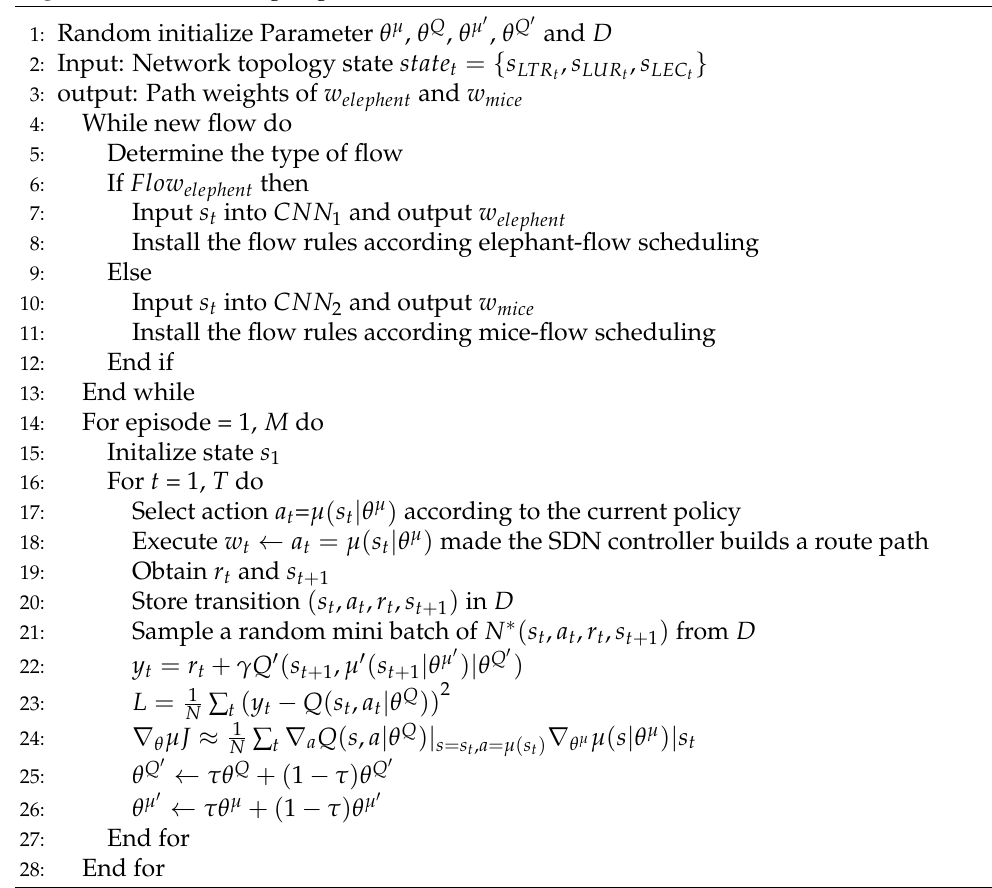
Algorithm 1 Ee-Routing Algorithm